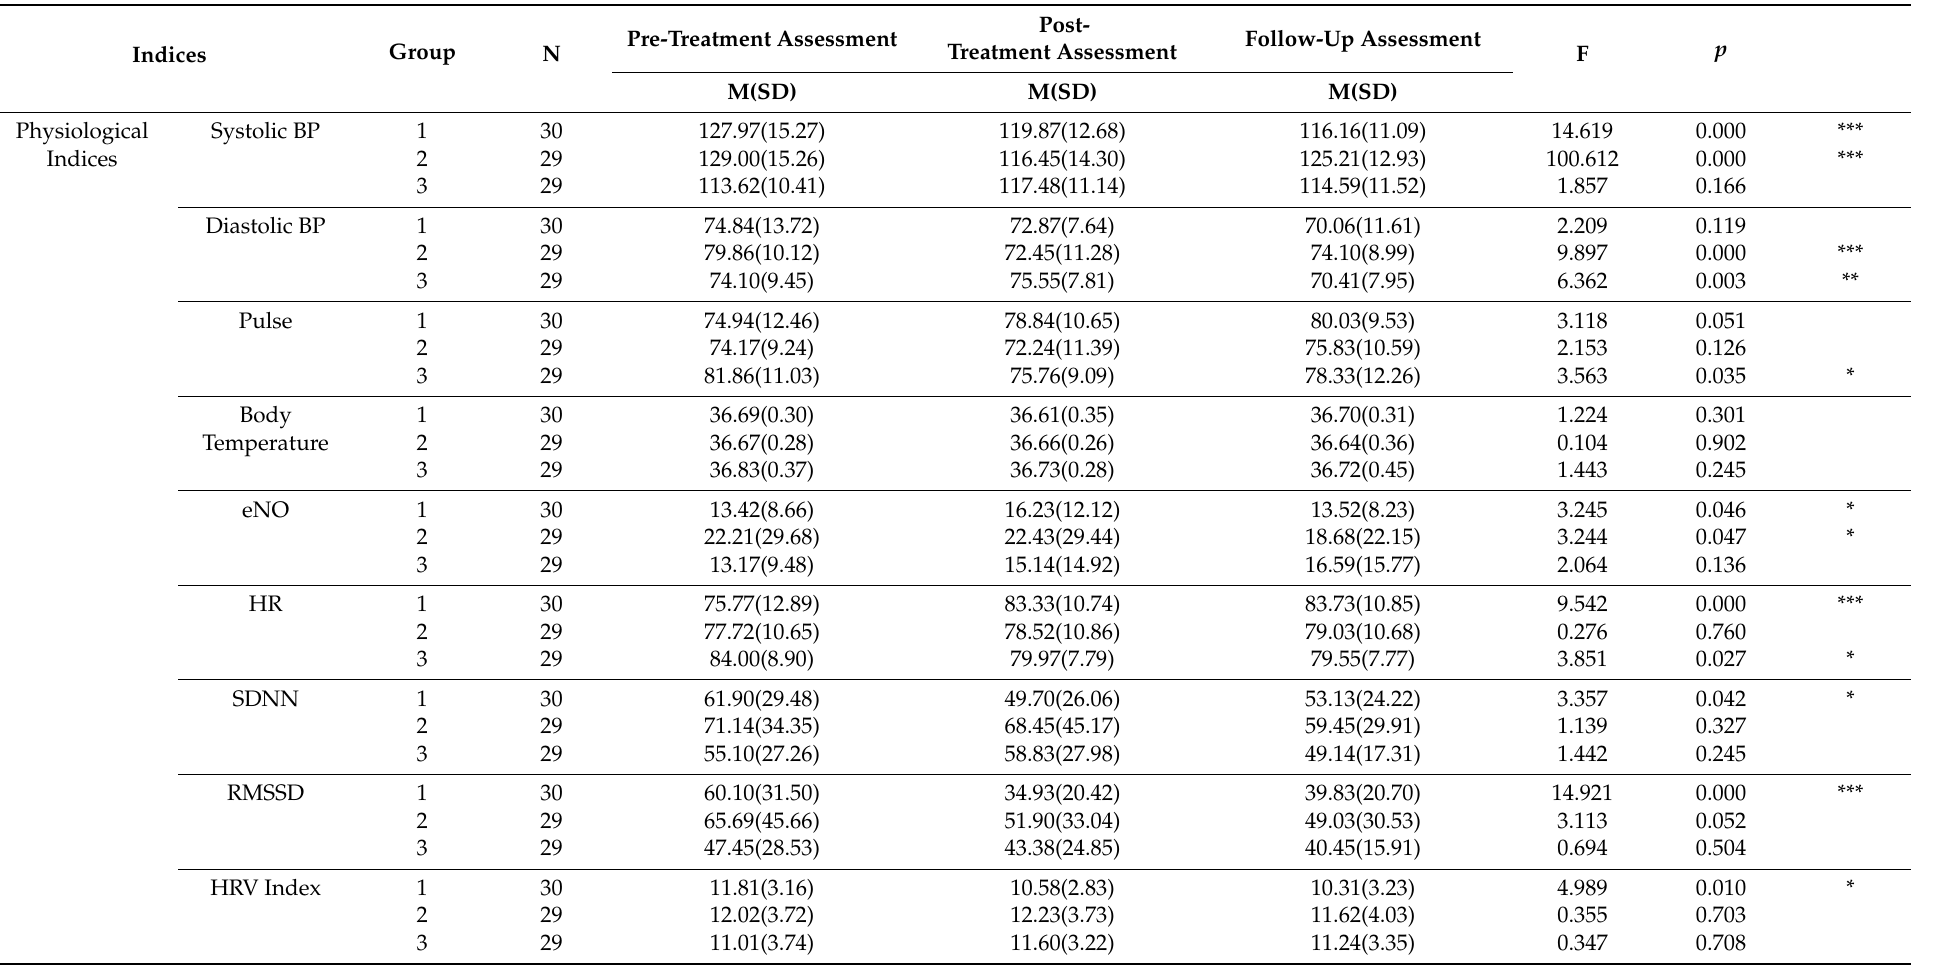
Table A3. Result Table of RM ANOVA by